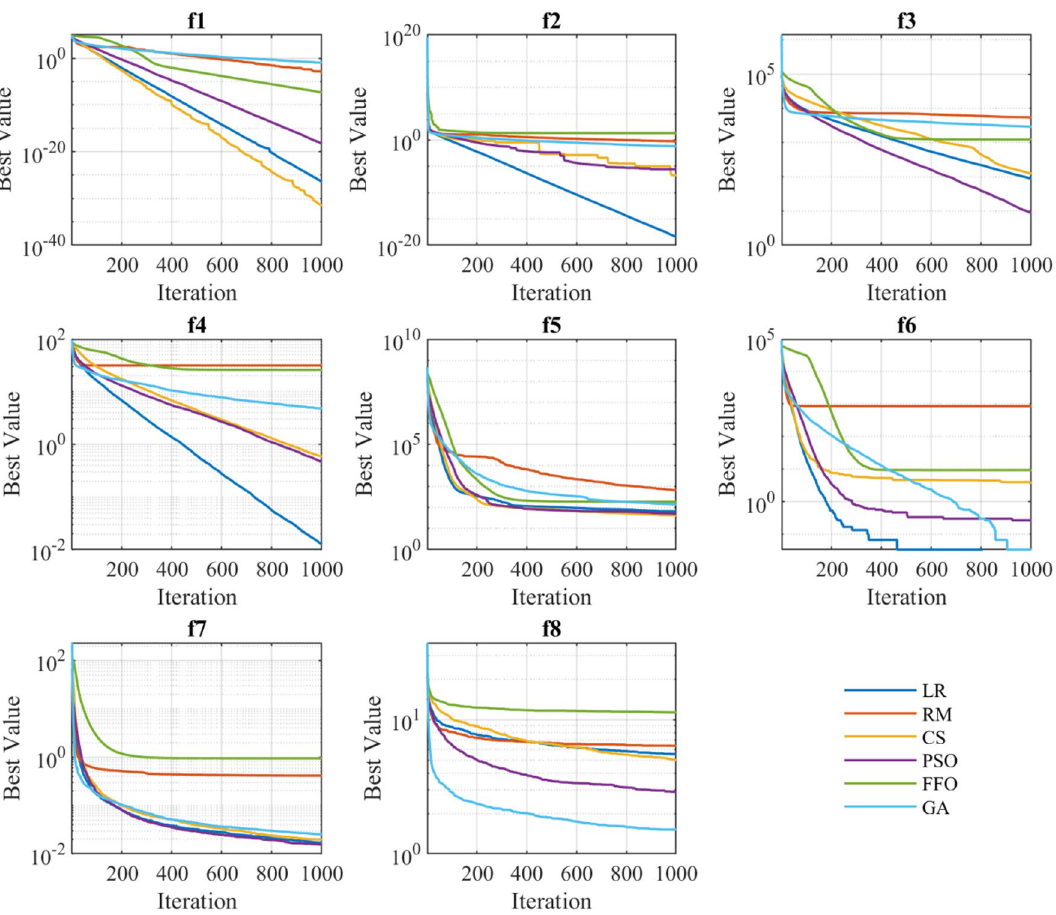
Figure 6. Convergence behaviour of the unimodal benchmark